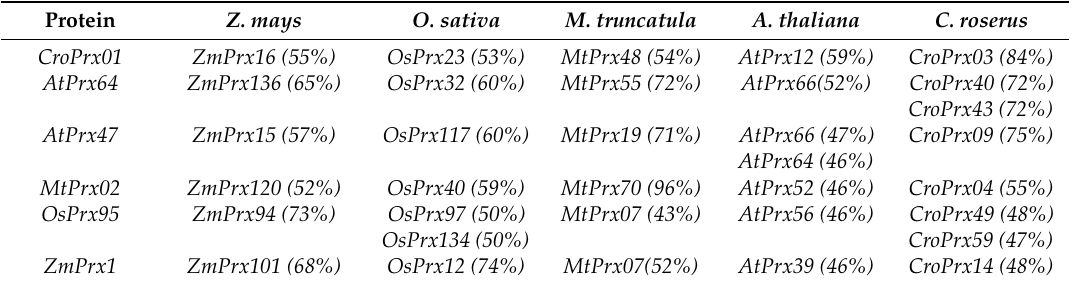
Table 3. Homologous and most similar sequences of membrane-bound class III peroxidases in other species. Sequence identity is given in brackets. Protein names are given according to